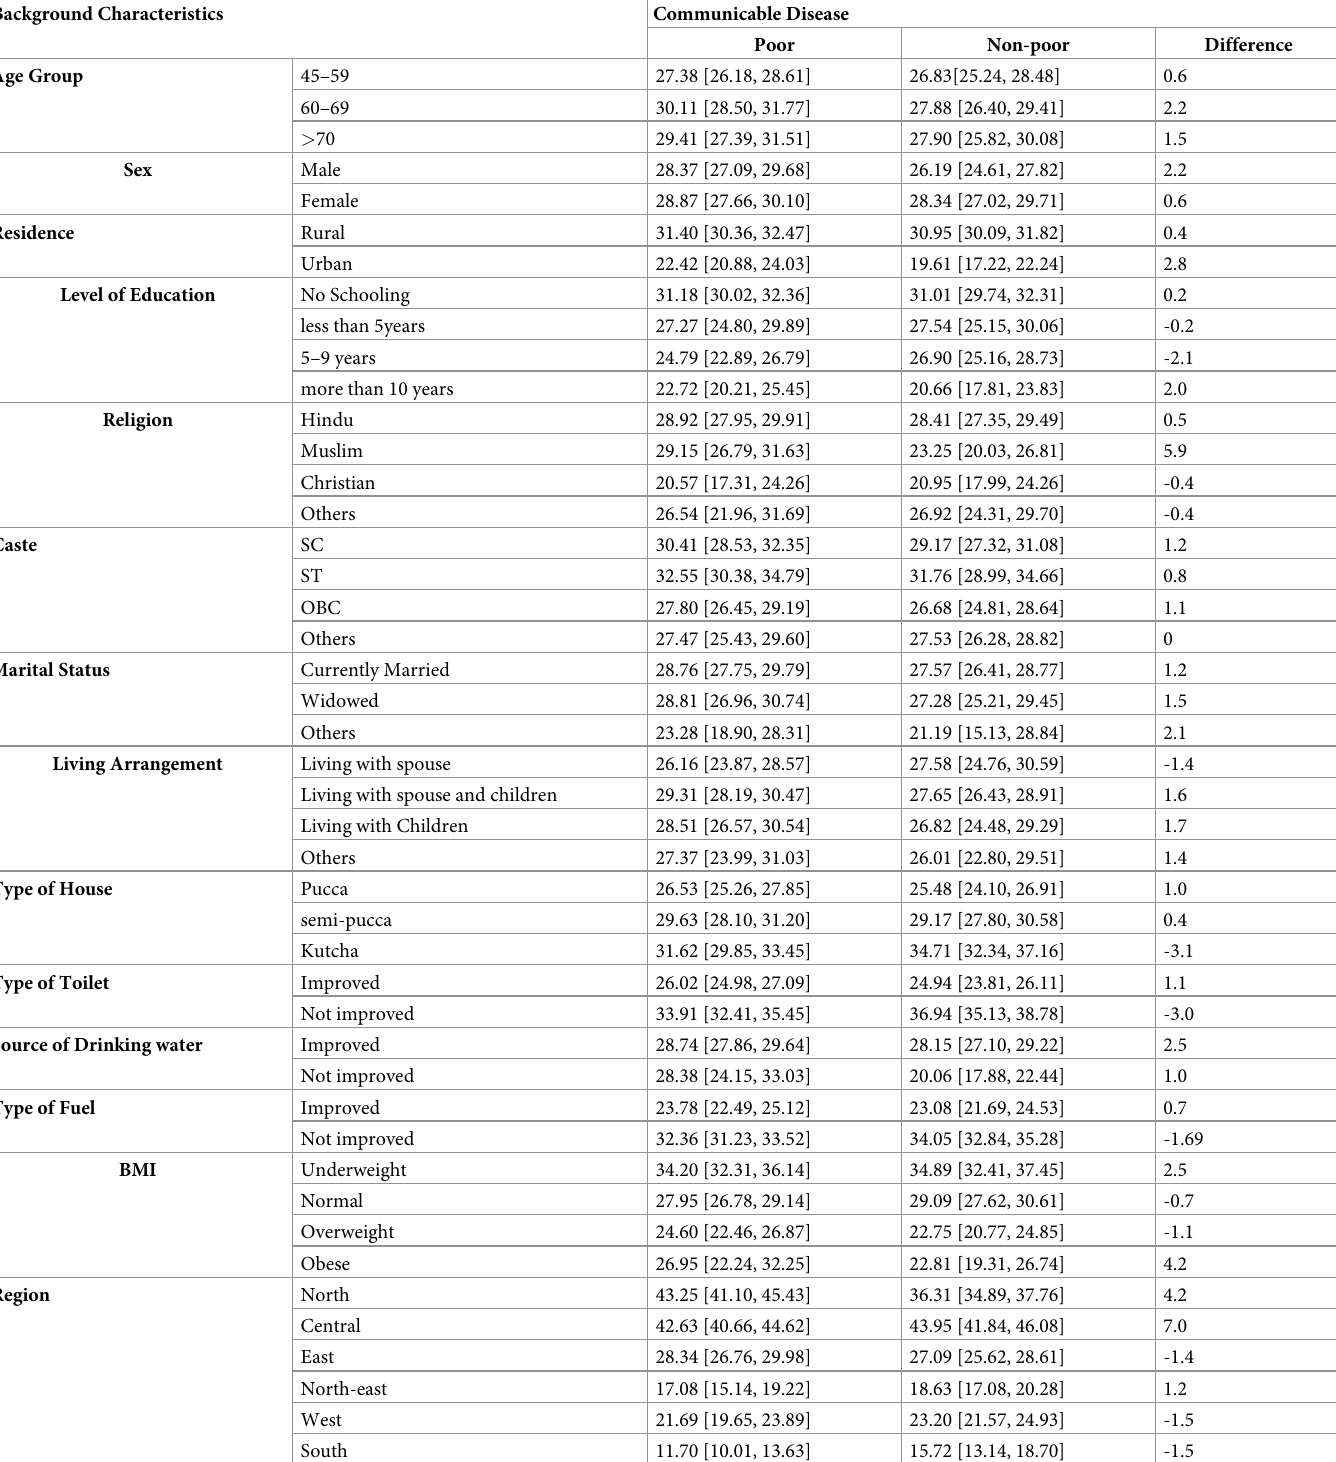
Table 2. Prevalence of communicable disease according to socio-economic characteristics in India. Background